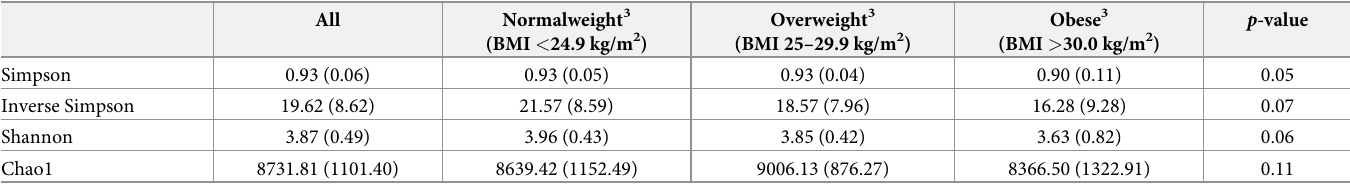
Table 2. Mean and standard deviation for alpha diversity metrics between BMI groups.